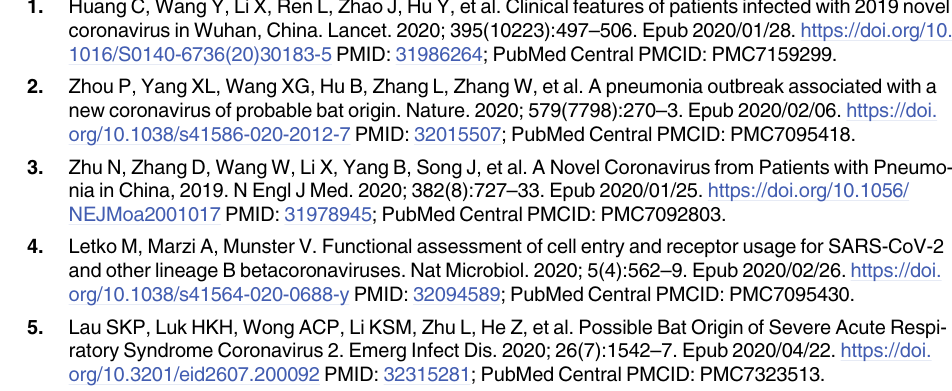
S2 Table. Primers used for SYBR Green qPCR gene expression profiling. Primers used for the amplification of deer mouse genes for the PCR expression array. Each primer is listed 5’ to